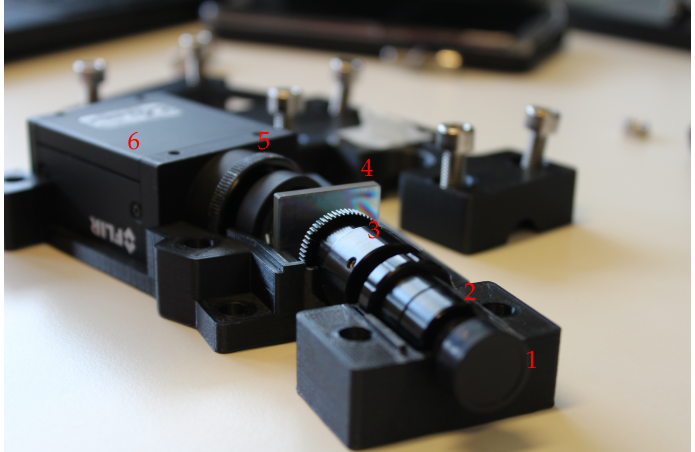
Figure 1. Our version of the Sigernes design push-broom imager with the top half removed. Light enters through the front lens (1). Connected to it is the series of S-mounts that contains the slit and the field lens (2), and the S-mount focus tube and the collimator lens (3). Diffraction grating (4) splits the light into its wavelengths. The detector lens (5) is connected to the machine vision camera (6).